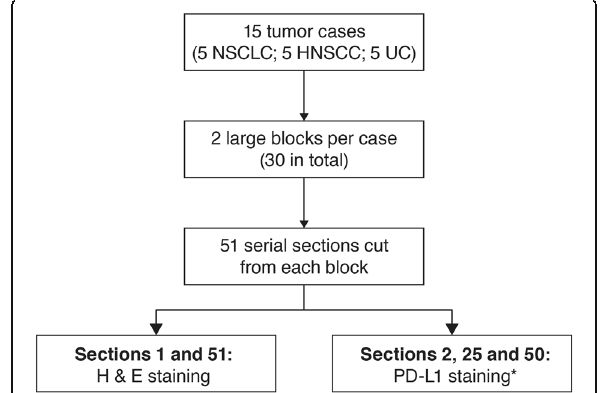
Fig. 1 Sample preparation from 15 NSCLC, HNSCC or UC